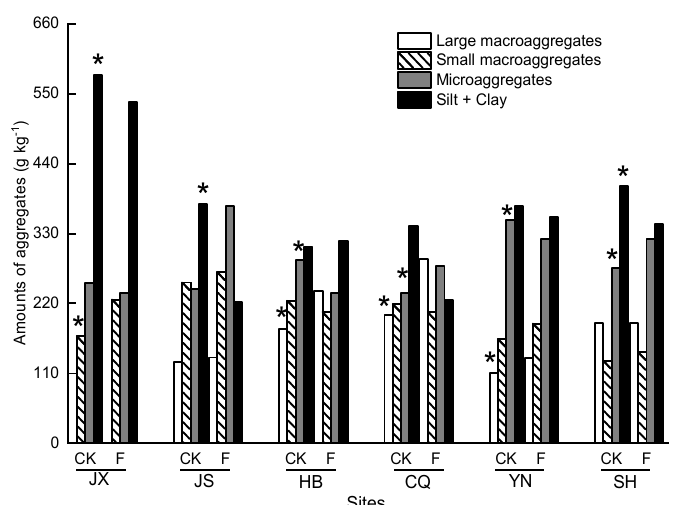
Figure 3. Amounts of aggregates in different T . Zhongshanshan plantations with increased age. The asterisks on the column indicate significant differences ( p < 0.05) between CK and F in each site. JX = Jiangxi; JS = Jiangsu; HB = Hubei; CQ = Chongqing; YN = Yunnan; SH = Shanghai; CK = non- forested soils; F = forested soils.